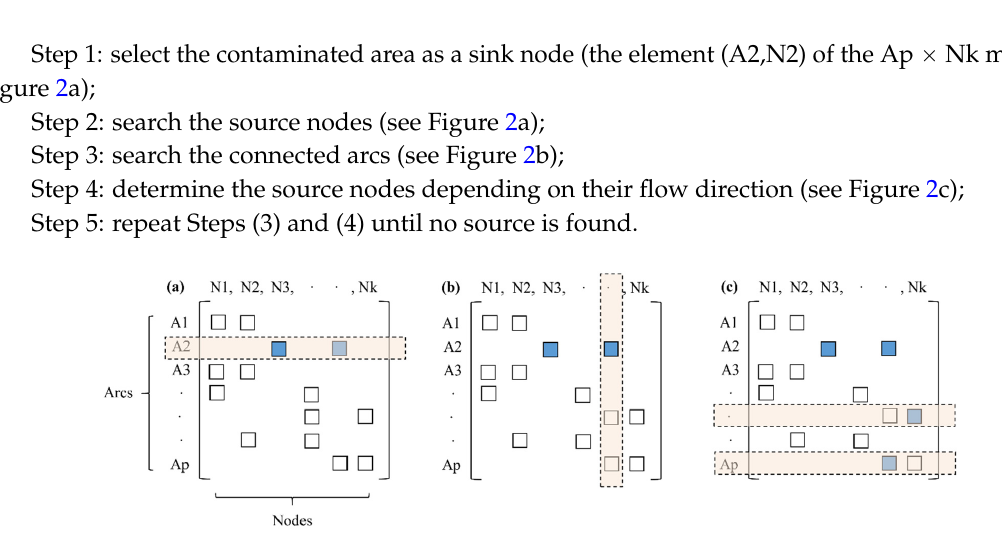
Figure 2. Network model representation for tracking the sources.